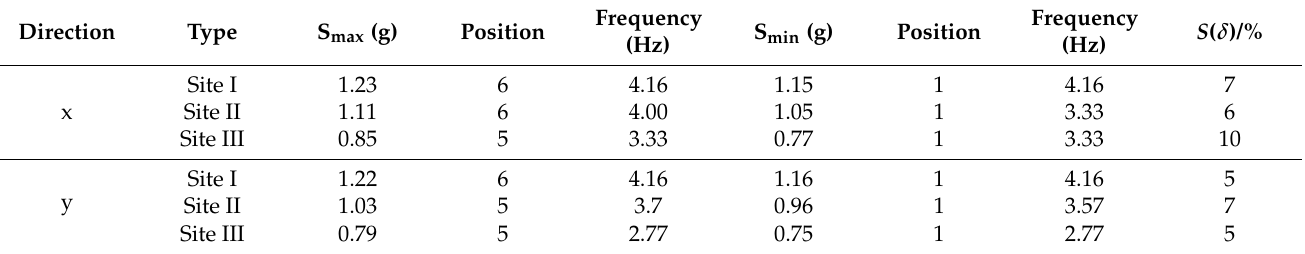
Table 3. Floor response spectrum at different positions of the raft foundation.